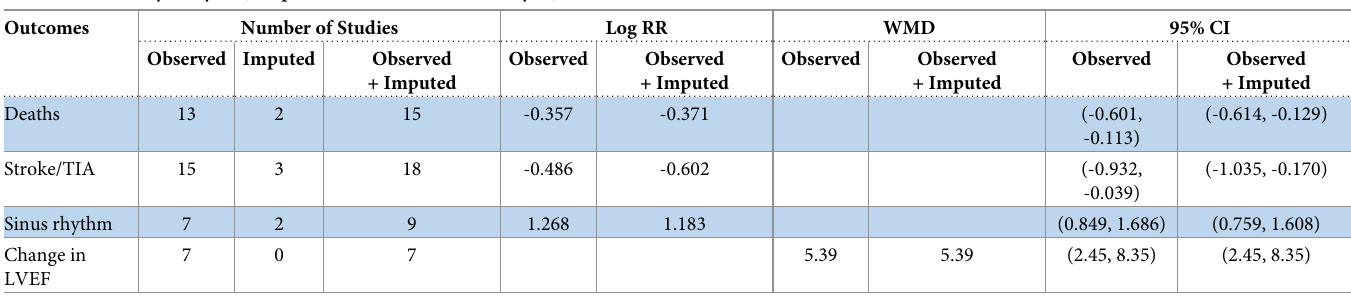
Table 3. Sensitivity analyses (nonparametric trim-and-fill analysis).